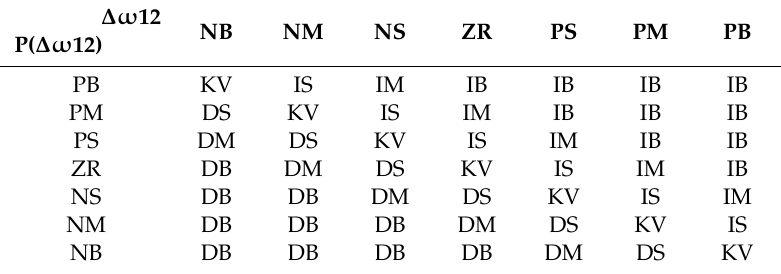
Figure 5. Diagram of the combined PID and FLC scheme [19]. Table 2. Regulation laws of the observed